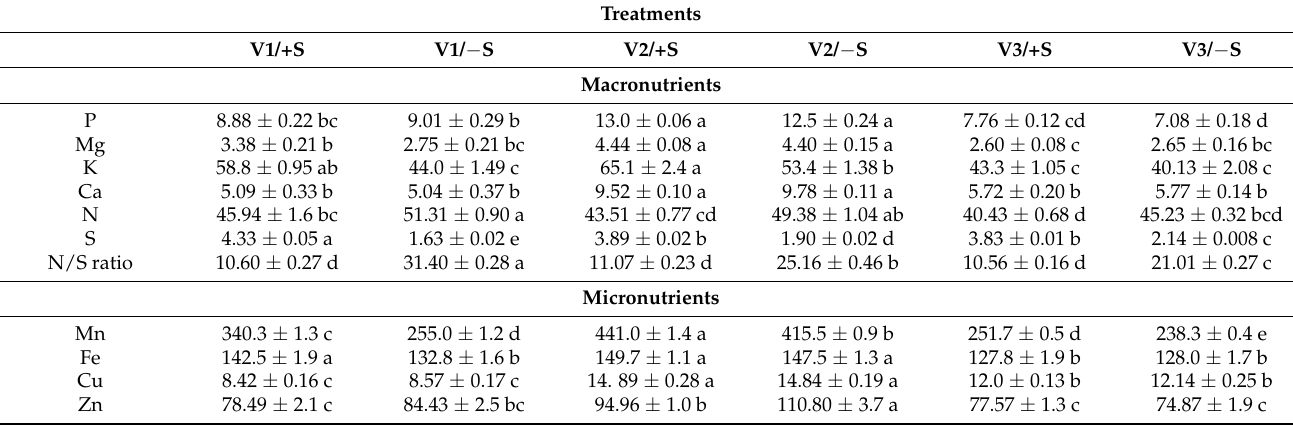
Table 2. Macronutrient (mg g − 1 DM) and micronutrient ( µ g g − 1 DM) concentrations in three lettuce cultivars; namely, Pazmanea RZ (green butterhead, V1), Hawking RZ (green multi-leaf lettuce, V2), and Barlach RZ (red multi-leaf, V3) grown in a hydroponic system and treated with magnesium sulfate (+S) or magnesium chloride ( − S) at a final concentration of 0.5 mM.